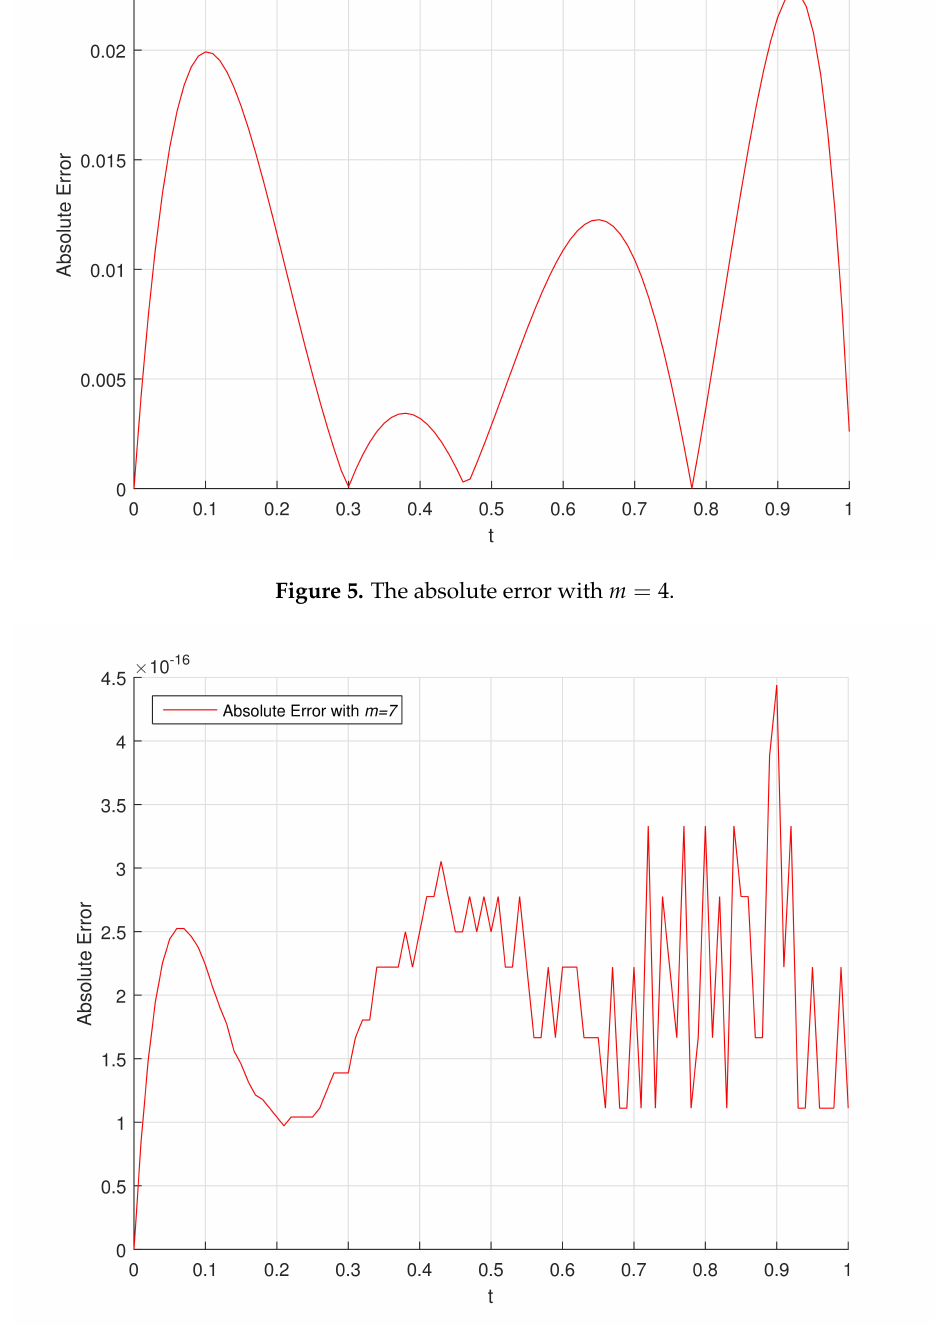
Figure 6. The absolute error with m =